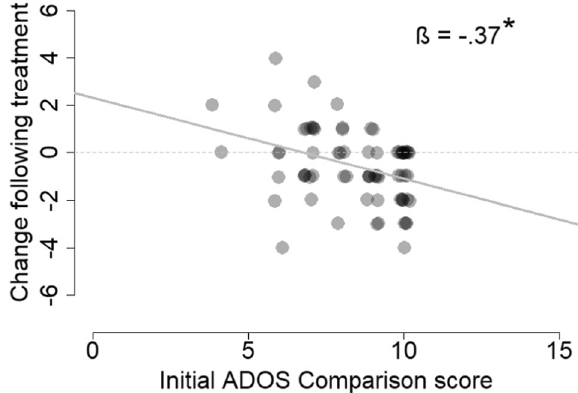
Fig. 2 Relationship between initial ADOS scores and change pre/ post treatment. Scatter plot demonstrating the relationship between initial ADOS CSS and change in ADOS CSS pre/post treatment. Asterisk: signi fi cant relationship ( p < 0.05, linear regres- sion). Gray line: regression line.